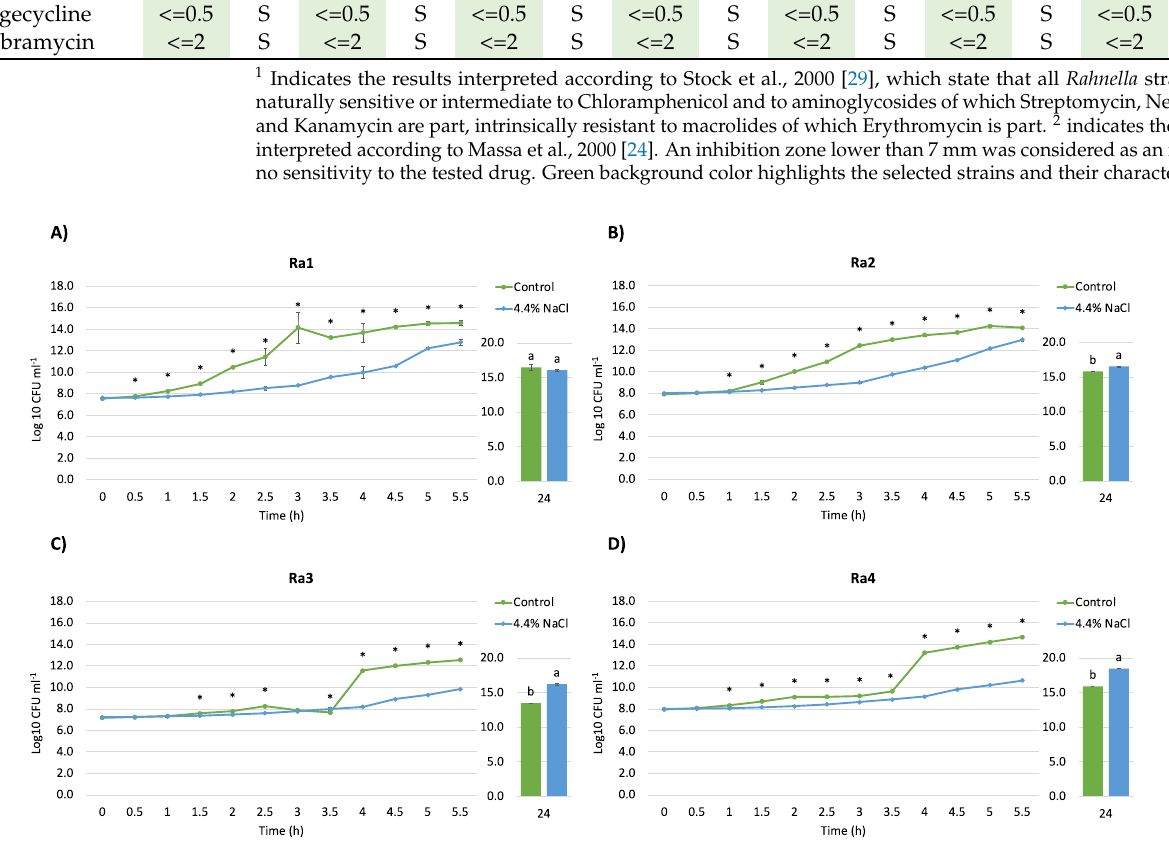
Figure 2. Growth curves of R. aquatilis strains. Effect induced by the treatment with 4.4% NaCl (light blue) compared to untreated cells (green) in the first 5.5 h and at 24 h of incubation (28 ◦ C in shaking) on the growth (Log10 cfu/mL) of the different bacterial strains: ( A ) R. aquatilis Ra1; ( B ) R. aquatilis Ra2; ( C ) R. aquatilis Ra3; ( D ) R. aquatilis Ra4. Asterisks and different letters indicate statistically significant differences between controls and salt-treated bacteria ( p -value <